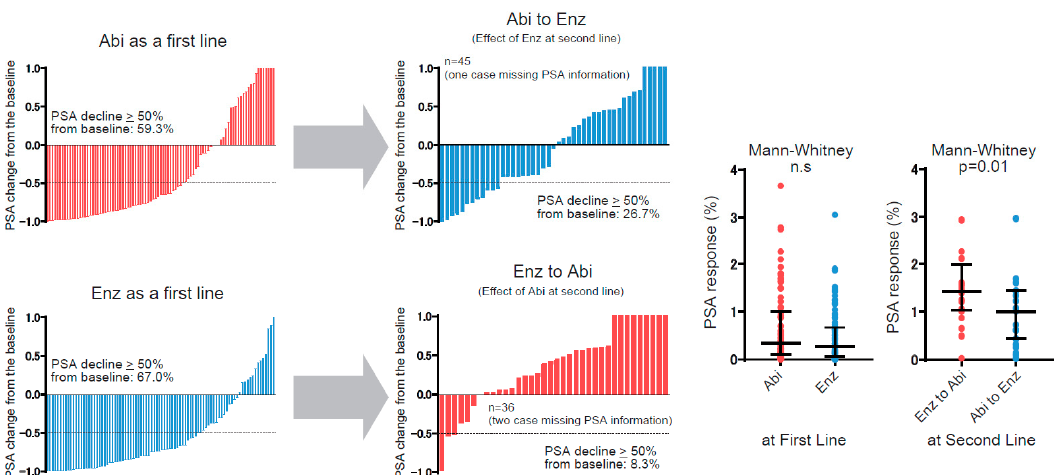
Figure 3. Waterfall plot illustrating the PSA response to first and second line androgen signaling inhibitors (ASIs). Dotted lines express the level of >50% PSA decline. In the first-line treatment, PSA decline of more than 50% from the baseline is observed in 59.3% (54 of 92) for abiraterone and 67% (60 of 92) for enzalutamide, with no significant difference (Chi-square: p = 0.28). In the second-line treatment, PSA decline of more than 50% from the initiation of second-line treatment is significantly less observed in abiraterone as a second line (8.3%) compared with enzalutamide following abiraterone (26.7%) (Chi-square: p = 0.03). PSA response from the baseline at each line is shown in the right panel. Table 2. Patient characteristics in 84 CRPC patients treated with ASIs as 2nd treatment.